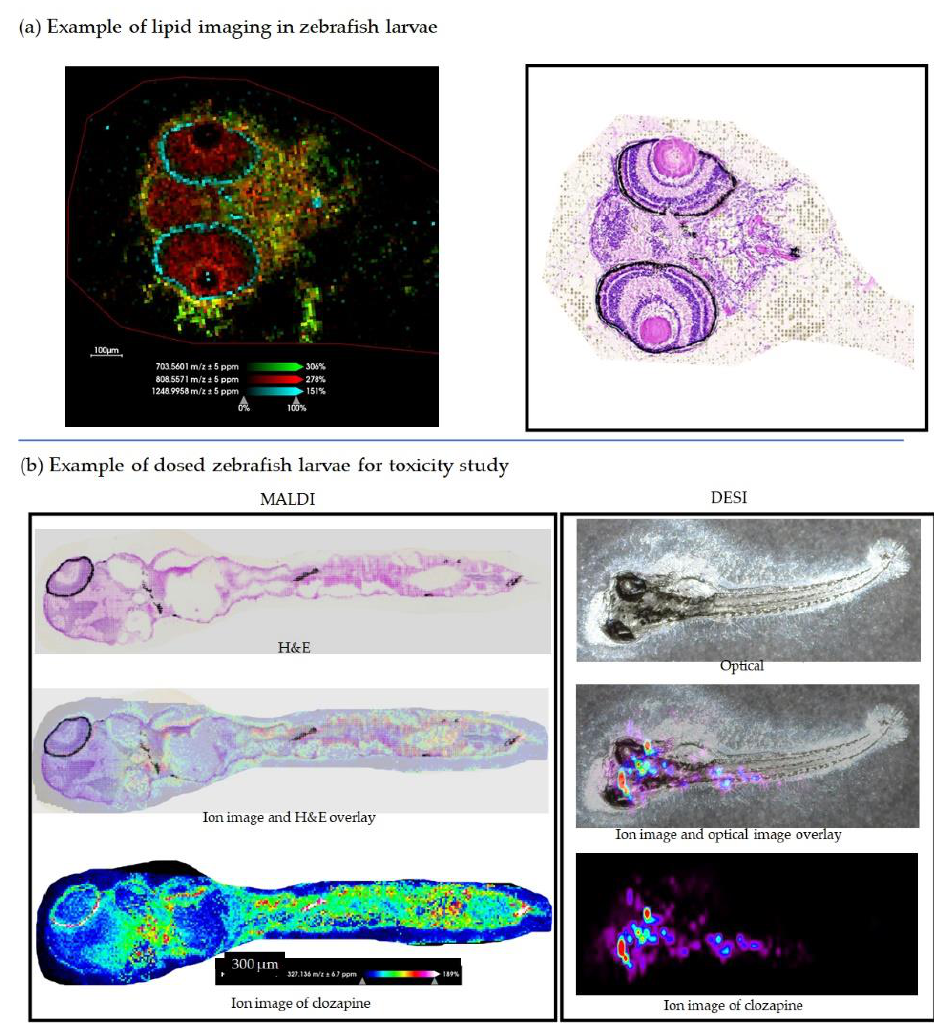
Figure 5. ( a ) Example of three ions distributed on the eyes and brain of zebrafish larvae (left, 10 µm spatial resolution) and H&E-stained optical image (right); ( b ) ion images of clozapine in dosed zebrafish larvae from MALDI (left, 10 µm spatial resolution) and DESI (right, 50 µm spatial resolution) experiments .